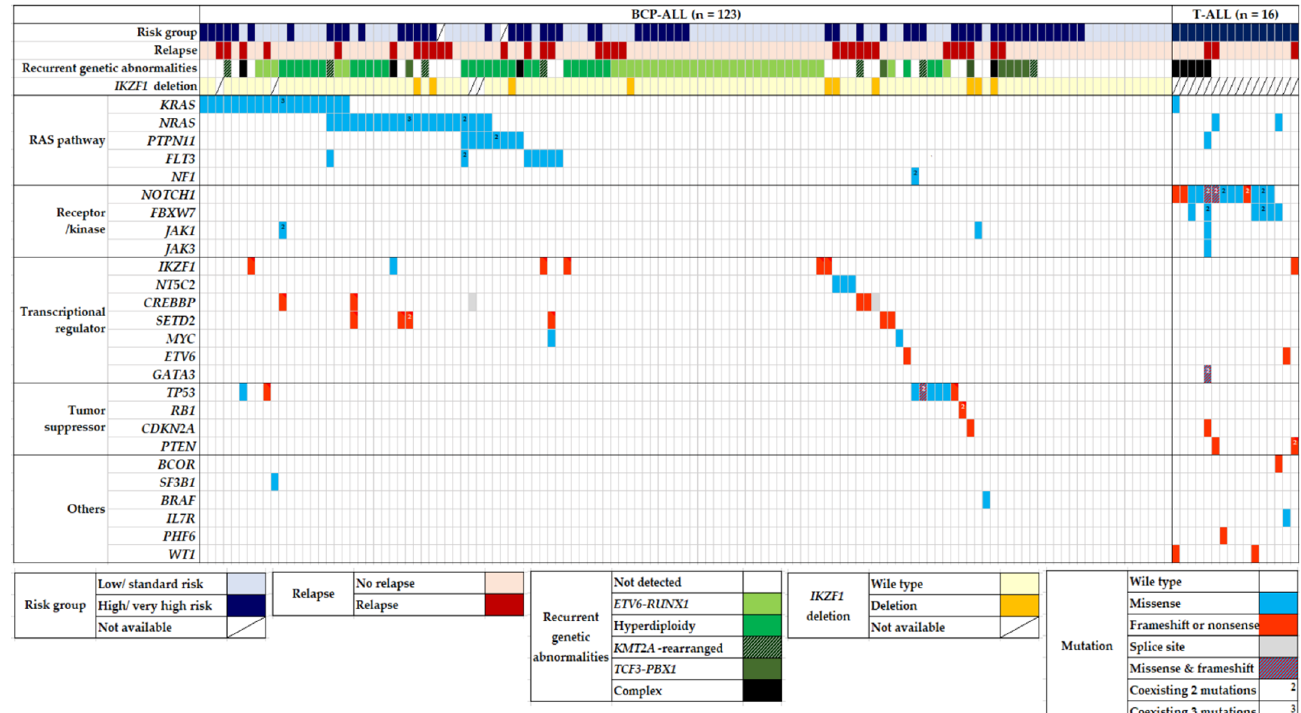
Figure 1. Mutational landscape of 139 pediatric ALL patients. Heatmap diagram showing genomic data of recurrent translocations, IKZF1 deletion, and somatic mutations in pediatric ALL. Abbreviation: BCP-ALL, B-cell precursor acute lymphoblastic leukemia.